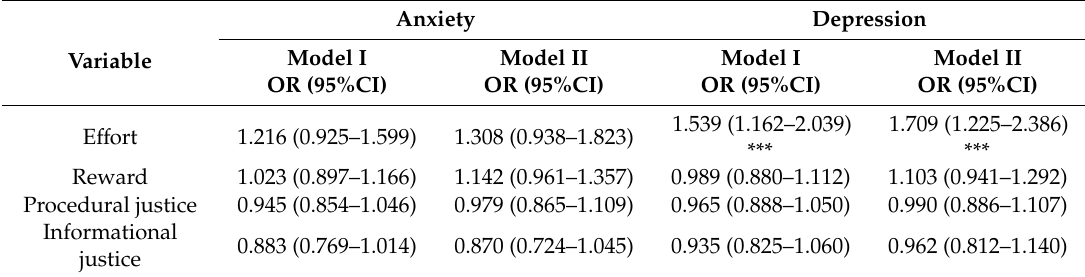
Table 5. Logistic regression analysis. Univariate and multivariate associations of work-related variables with anxiety and depression cases in